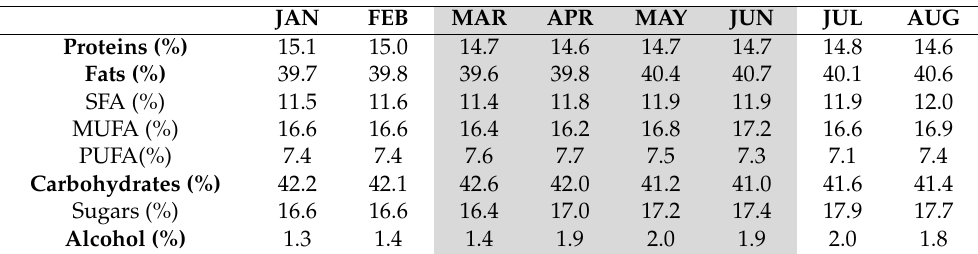
Table 3. Macronutrients and alcohol distribution estimated from food and beverages purchased in Spanish households in 2020 (% of the energy).